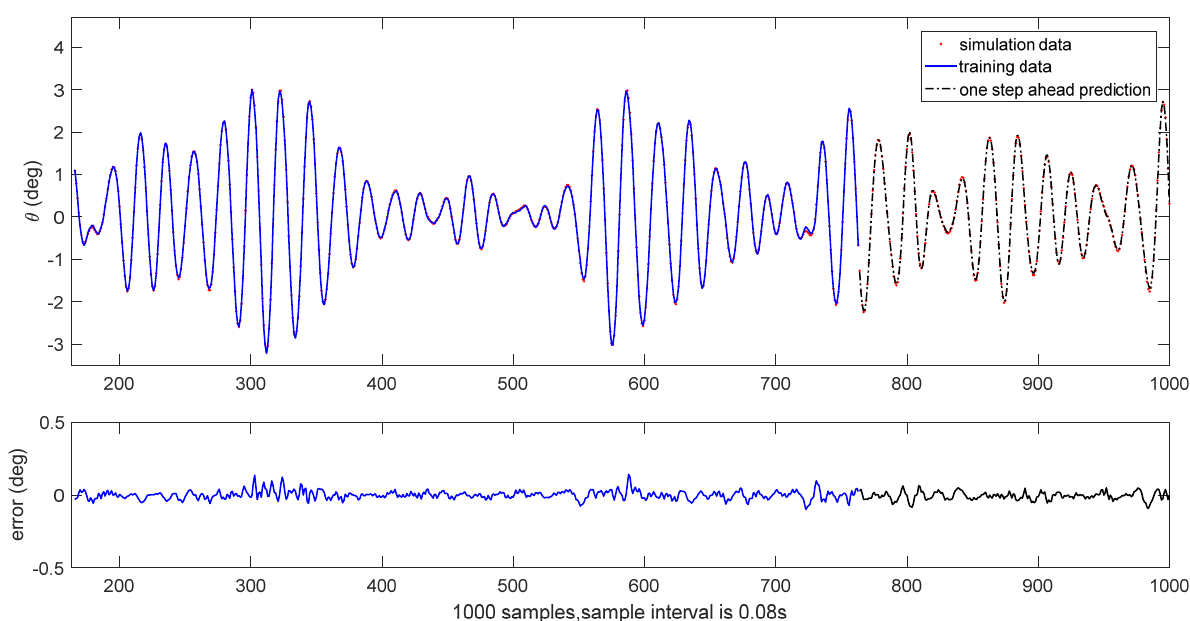
Figure 19. The one-step ahead prediction of pitch motion in irregular waves at the instant k = 763 for the FPSO model.